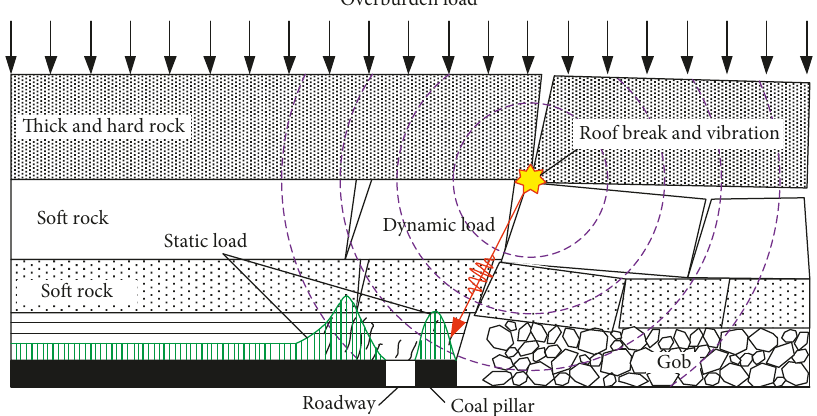
Figure 1: Schematic of the mechanism of coal burst induced by high static load and dynamic load